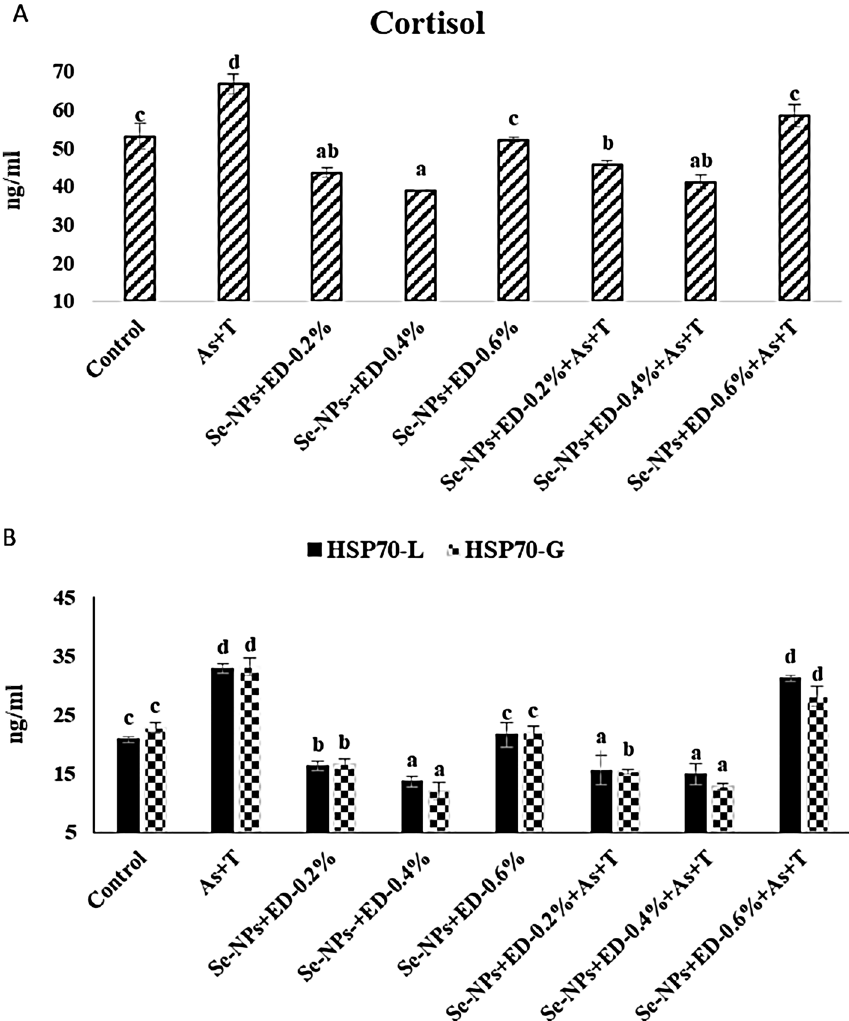
Figure 2. ( A , B ) Mitigation of primary and secodary stress response (Cortisol and HSP 70) through dietary supplementation of selenium nanoparticles, eicosapentanoic acid and dicosahexanoic acid fed to P. hypophthalmus reared in control or under arsenic and high temperature (As + T) for 105 days. Within endpoints and groups, bars with different superscripts differ significantly (a–d) cortisol (p = 0.032), HSP-L (p = 0.026), HSP-G (p = 0.014). Data expressed as Mean ± SE (n = 3).